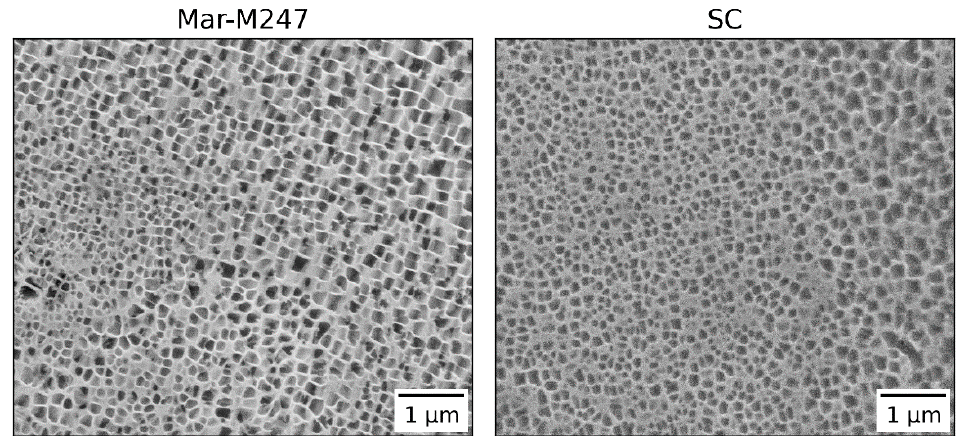
Figure 3. Microstructures of reference alloy Mar-M247 and SC alloy in as-cast state. γ matrix is light-colored, while γ′ precipitates are dark. γ′ phase fractions are high, as is typical for nickel-base superalloys.